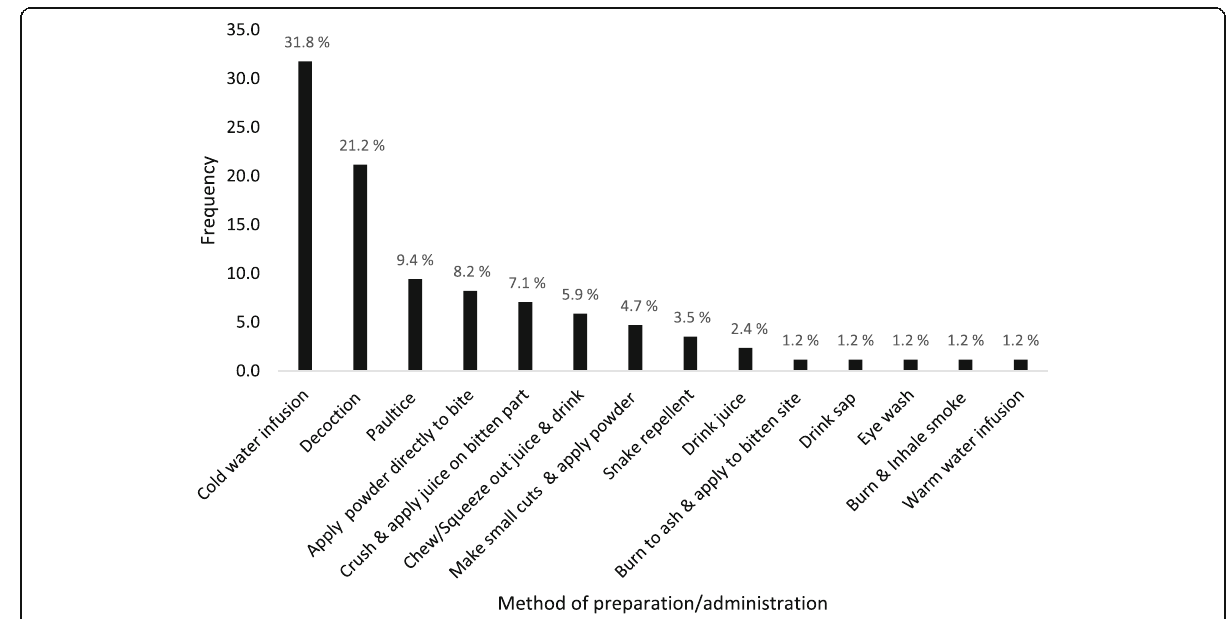
Fig. 4 Methods of preparation/administration of the herbal medicines in the Acholi, Teso and Karamoja sub regions of